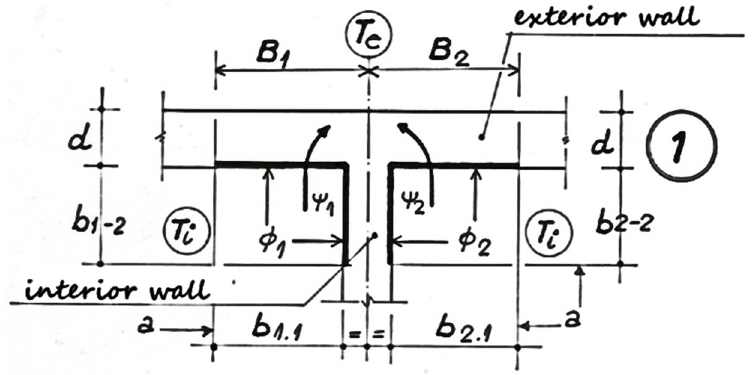
Figure 7. ψ value calculation following the Annex J approach from C107/3. Adapted from [31].